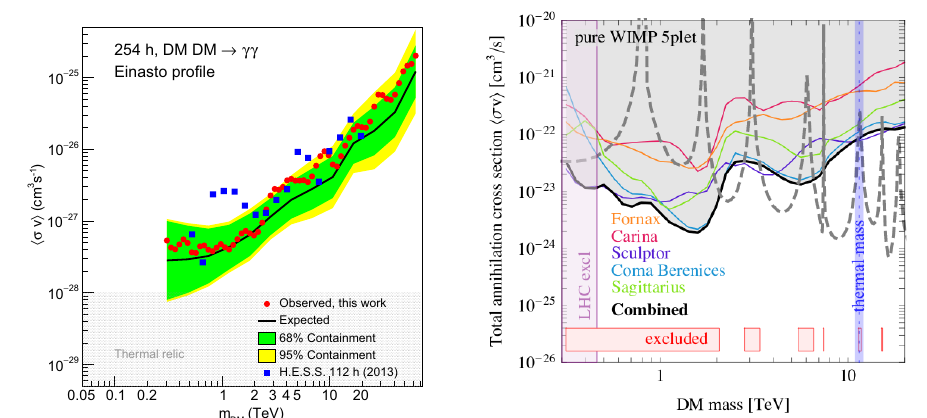
Figure 2. 95% C. L. upper limits on (cid:3) σv (cid:4) as a function of m DM . Left: Limits for the g amma-line derived from H.E.S.S. observations taken over ten years (254 h live time) of the inner 300 pc of the GC region. Observed limits (red dots) and mean expected limit (black solid line) are shown together with the 1 σ (green band) and 2 σ (yellow band) containment bands. Right: Limits for the 5plet towards dwarf galaxies are shown for single galaxy observation and for their combination (black solid line). The predicted cross section (gray dashed line), thermal mass (blue band) and excluded masses (red boxes) are